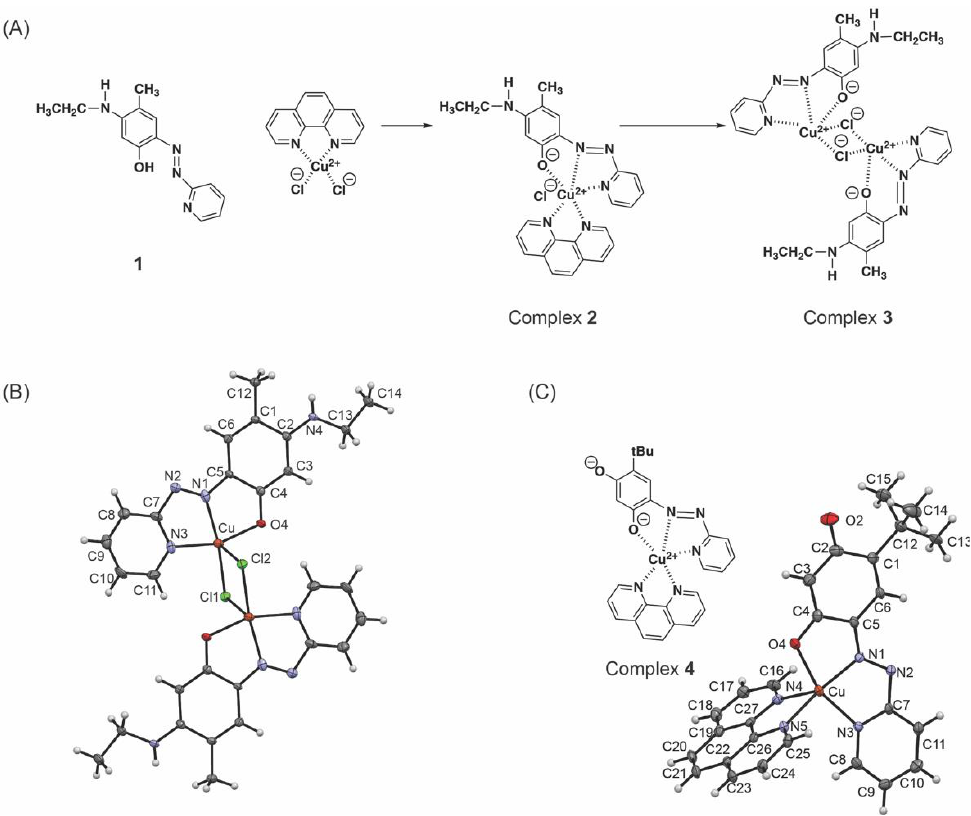
Figure 5. Structures of model compounds in this study ( A ) Complex 2 was generated in methanol solution by mixing equimolar amounts of 1 and dichloro(1,10-phenanthroline)Cu(II). Crystallization of Complex 2 by slow evaporation of methanol yielded Complex 3 . ( B ) An ORTEP view of the X-ray crystal structure of Complex 3 [30]. ( C ) Structure of Complex 4 (left) and an ORTEP view of Complex 4 (right) [29]. Displacement ellipsoids are shown at the 50% probability level. Symmetry code: −x+1, −y, −z. Copper: in copper, carbon: in black, nitrogen: in blue, oxygen: in red, chloride: in green, hydrogen: in white. The atom labeling system here is aligned with those used for LTQ and TPQ cofactor labeling in proteins [4,31]. Although Complex 3 is symmetrical, two Cl atoms are labeled Cl1 and Cl2 to address the coordination geometry of the Cu(II) center.